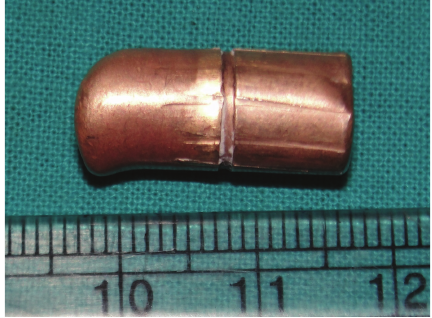
Figure 9: The bullet after removal (2 cm × 0.9 cm).